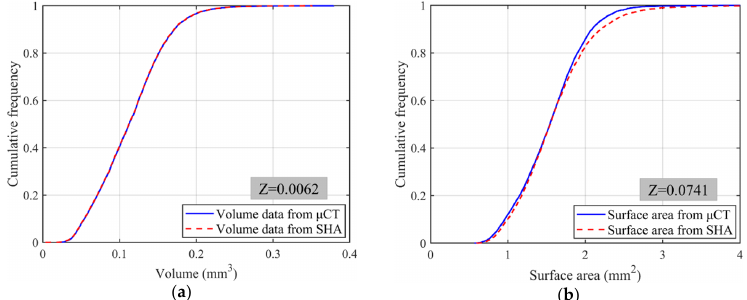
Figure 3. Comparisons between cumulative distributions of 4155 Leighton Buzzard sand (LBS) particles from μ CT and spherical harmonic analysis (SHA): ( a ) particle volume; ( b ) particle surface area.